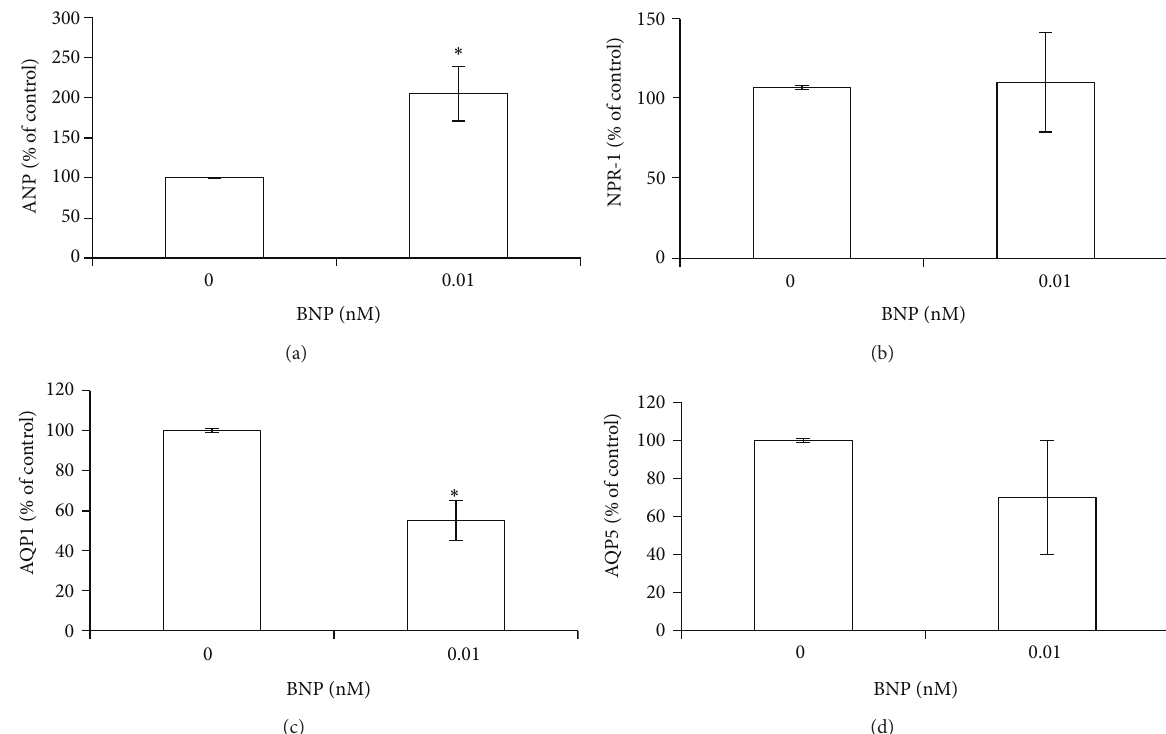
Figure 8: BNP effect on ANP, NPR-1, AQP1, and AQP5 expression.BEAS-2B cells were treated with 0.01nM BNP for 24h. Histograms show (a) ANP, (b) NPR-1, (c) AQP1, and (d) AQP5 gene expression at mRNA level. All histograms indicate means ± SD of three different cultures each one tested in quadruplicate and expressed as percentage of control ( ∗ 𝑃 < 0.05 versus untreated cells).